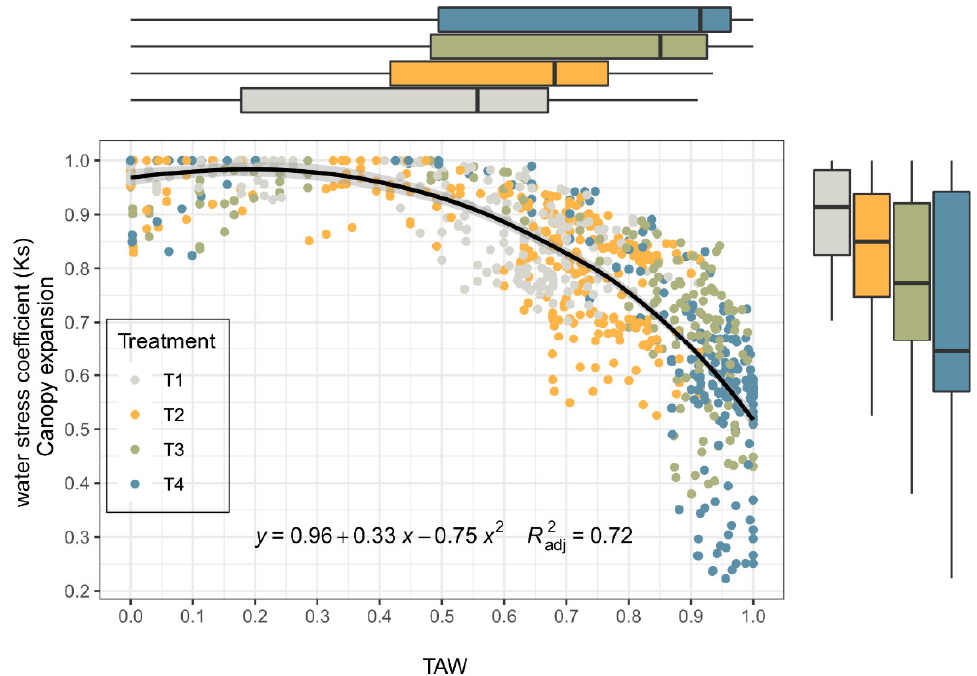
Figure 7. Relationship between stress coefficients ( Ks ) for canopy expansion (exp) and relative availability of soil water during a stress cycle ryegrass ( Lolium perenne ). Treatment are color coded. T1: moderate–low water stress treatment (grey color), T2: moderate–high water stress treatment (yellow color), T3: medium intensity severe water stress treatment (green color), T4: high intensity severe water stress treatment (blue color).